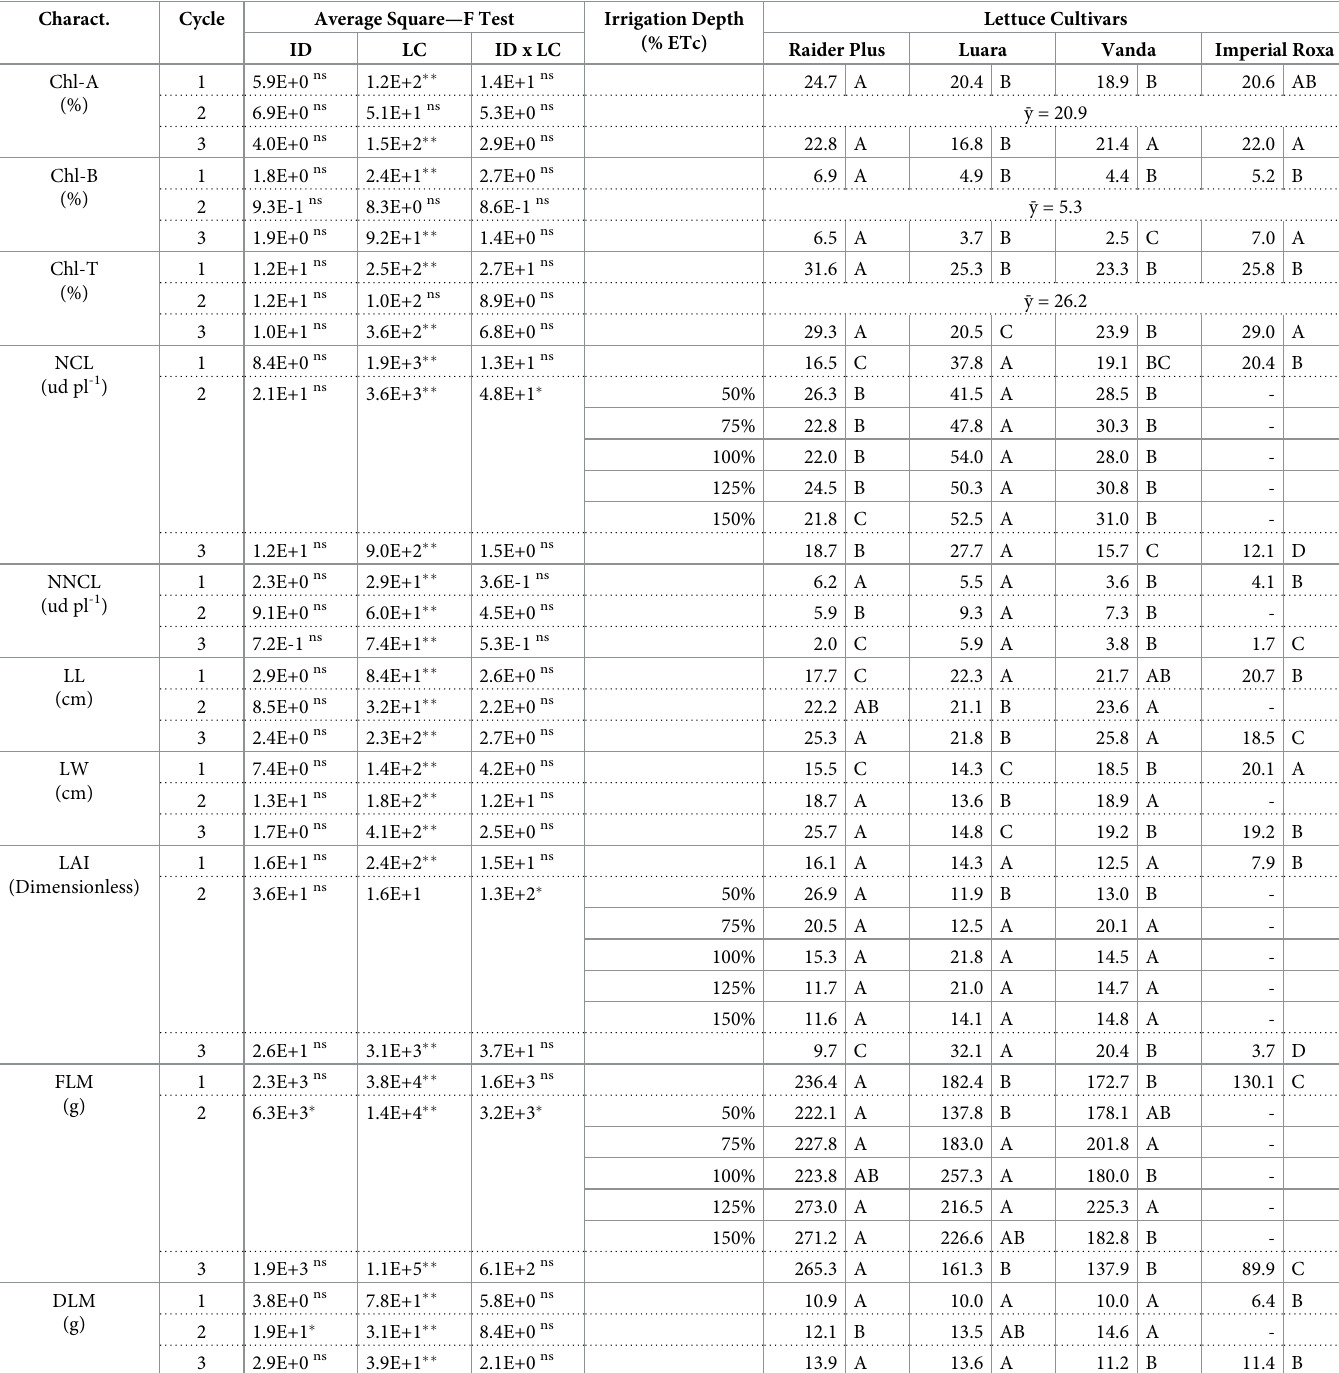
Table 3. Average squares, significance of the F test (ANOVA) and average values for leaf characteristics: relative content of chlorophylls A (Chl-A) and B (Chl-B) and of total chlorophyll (Chl-T), number of commercial leaves (NCL), number of noncommercial leaves (NNCL), leaf length and width (LL and LW), leaf area index (LAI), fresh leaf mass (FLM), and dry leaf mass (DLM g) as a function of different cultivars and irrigation depths in three lettuce crop cycles.